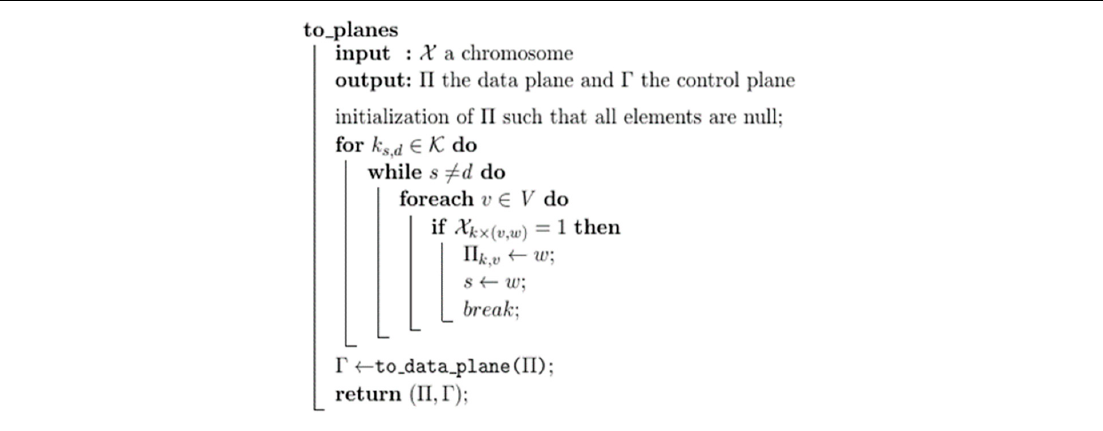
Algorithm 1. Retrieval of data and control plane from chromosome.